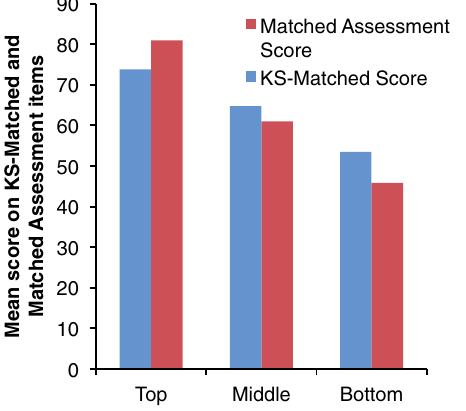
FIG. 5. Average KS-matched scores and actual scores on the matched assessment items broken out by student groupings based on the overall score on the final exam for Chemistry 110.